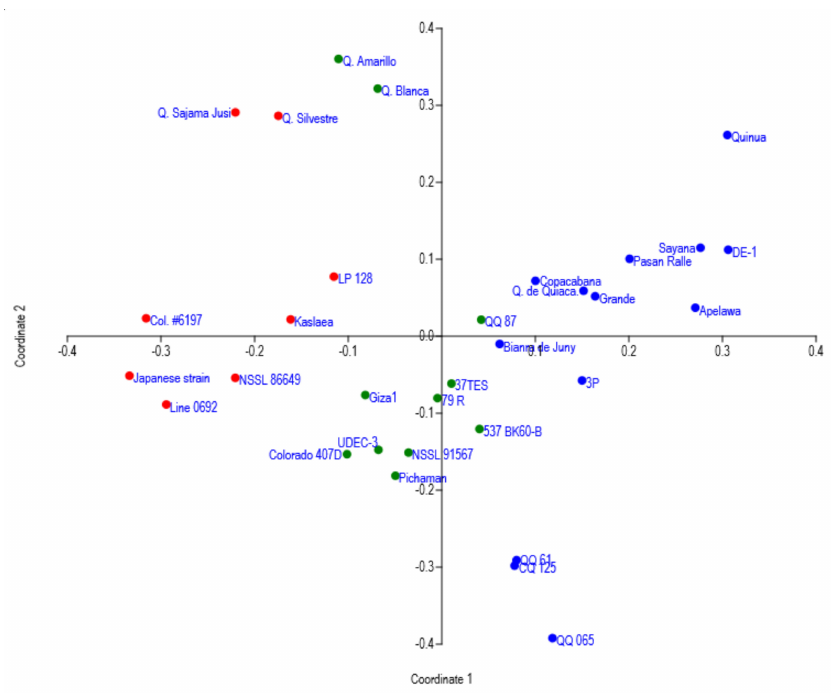
Figure 6. Principal coordinate analysis results confirming the presence of two main groups and one admixture. The first coordinate contributed by 17.4 and the second coordinate by 13.0 of the total